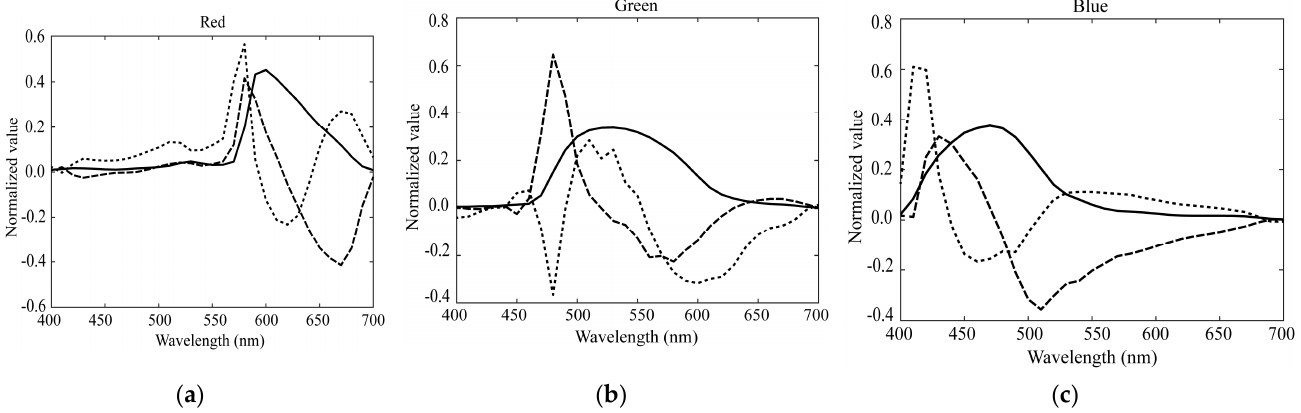
u u u , 2 , and 3 for the ( a ) red, ( b ) green, and ( c ) blue channels of the spec-